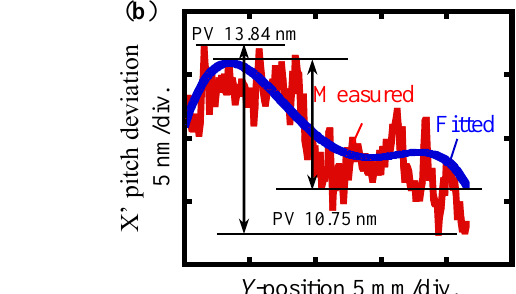
Figure 8. Central cross-sections of the X ′ -directional pitch deviation shown in Figure 7. ( a ) Central cross-section along the X -direction; ( b ) Central cross-section along the Y -direction.